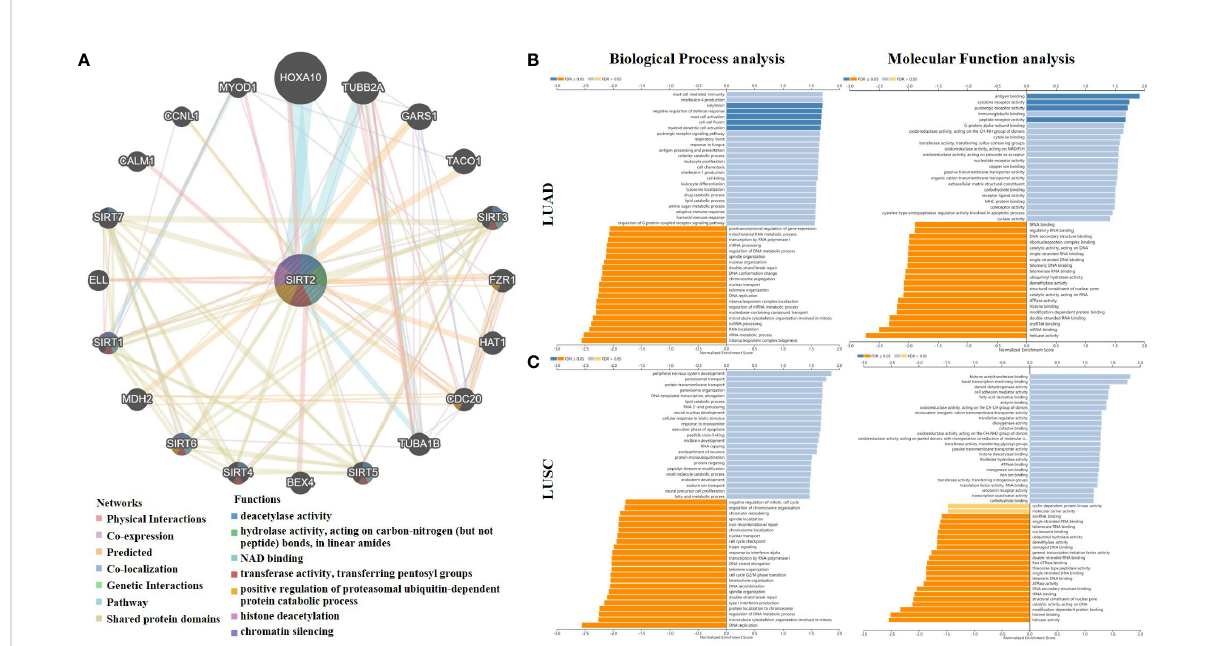
FIGURE 4 SIRT2-related gene enrichment analysis by using GENEMANIA and LinkedOmics. (A) A TCGA SIRT2 interaction network. Lines in different colors represent different bioinformatics methods, and rings in different colors represent different gene functions. Analysis of SIRT2 correlated genes in LUAD (B) , LUSC (C) using the Gene Ontology for Biological Process and Molecular Function. In dark blue and orange, FDR is less than 0.05, in light blue and orange, FDR is greater than 0.05. FDR stands for false discovery